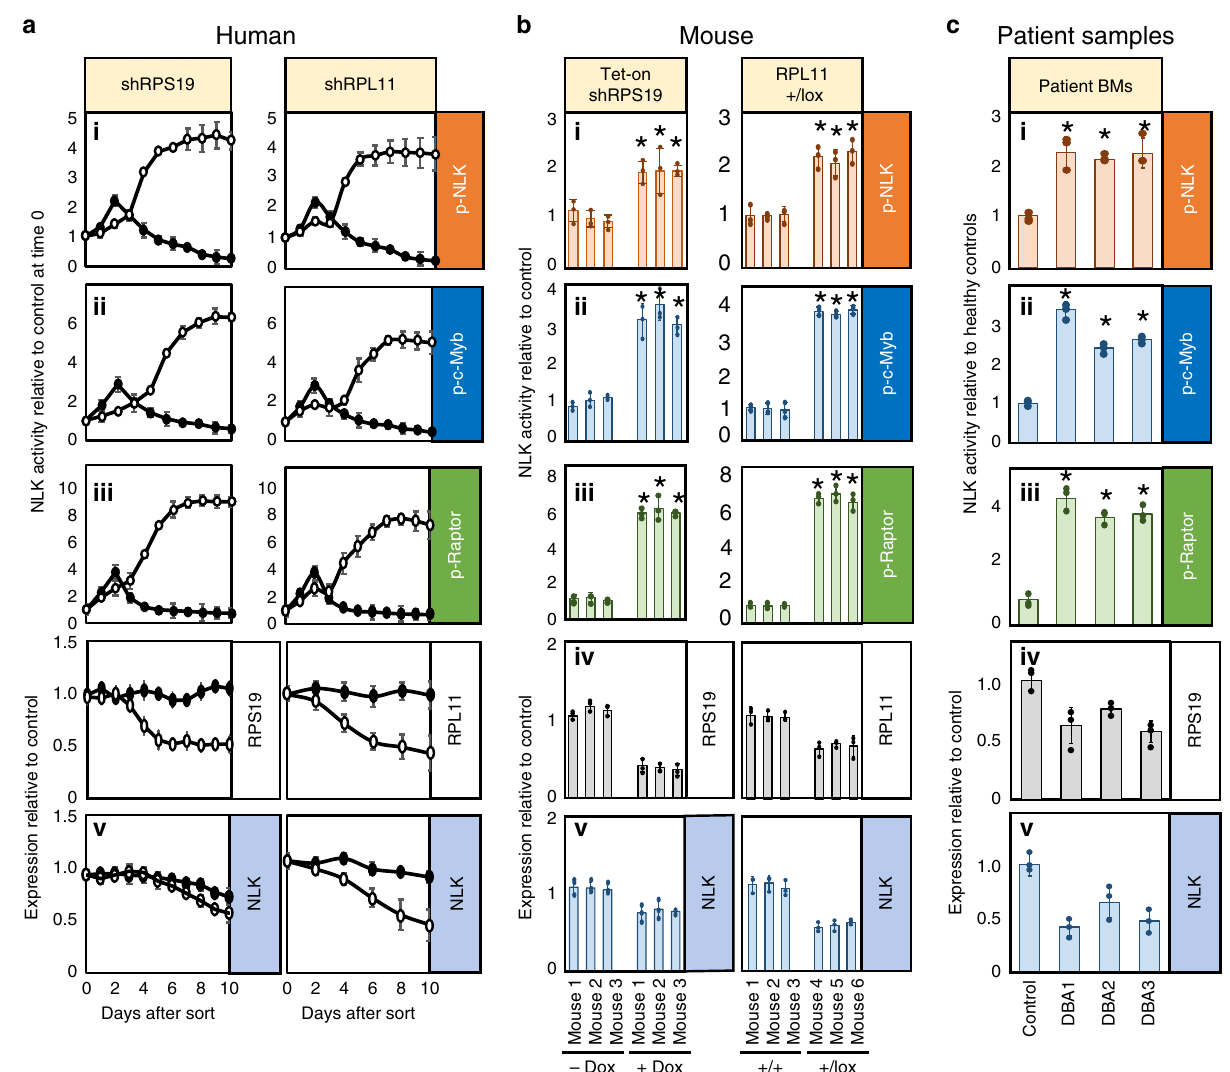
Fig. 4 NLK is activated in erythroid progenitors from human and murine models of DBA and DBA patient bone marrow. a Cord blood CD34 + progenitors were transduced with lentivirus co-expressing shRNA against luciferase (shLuc), RPS19 (shRPS19) or RPL11 (shRPL11) and GFP. After 36 h GFP + cells were differentiated in erythroid media for the indicated days prior to immunopurifying NLK for kinase assay measuring in vitro phosphorylation of NLK (i — orange), c-Myb (ii — blue) and Raptor (iii — green) and assessment of RPS19/RPL11 (iv — gray), and NLK (v — blue) expression by qRT-PCR. Solid circles indicate shLuc while open circles indicate shRPS19 or shRPL11. b Lin - Kit + hematopoietic progenitors were obtained from mouse embryos expressing tetracycline-inducible shRNA against RPS19, at day E14.5. Cells were grown in the presence or absence of doxycycline for 8 days and subjected to NLK kinase assay qRT-PCR for expression of murine RPS19 and NLK (b-left). Lin - Kit + progenitors were puri fi ed from bone marrow of 3 RPL11 + / + and 3 RPL11 + /lox tamoxifen-treated mice and analyzed for NLK activity by kinase assay, as well as NLK and RPL11 expression by qRT-PCR (b-right). c NLK was immunopuri fi ed from 5000 bone marrow mononuclear cells derived from bone marrow aspirates of healthy control and three DBA patients carrying RPS19 mutations. Bars represent means± SD with individual data points overlaid. n = 3 independent experiments performed in triplicate. Statistics: two-tailed Student ’ s t test, signi fi cant * p < 0.05.Also see Supplementary Fig. 5. Source data are provided as a Source Data fi